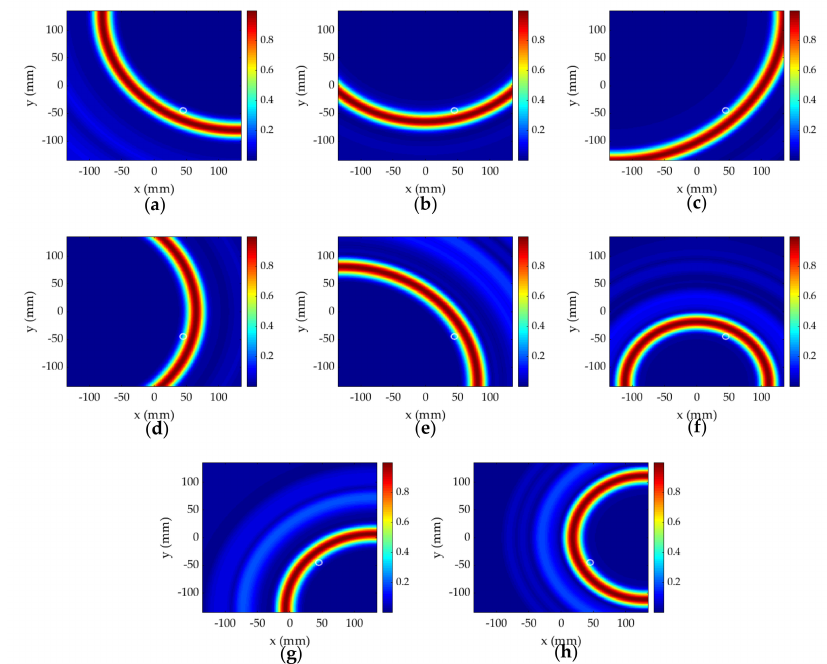
Figure 12. Possibilities of damage existence in pulse–echo configuration for sensing paths: ( a ) A1B1; ( b ) A2B2; ( c ) A3B3; ( d ) A4B4; ( e ) A5B5; ( f ) A6B6; ( g ) A7B7; ( h )